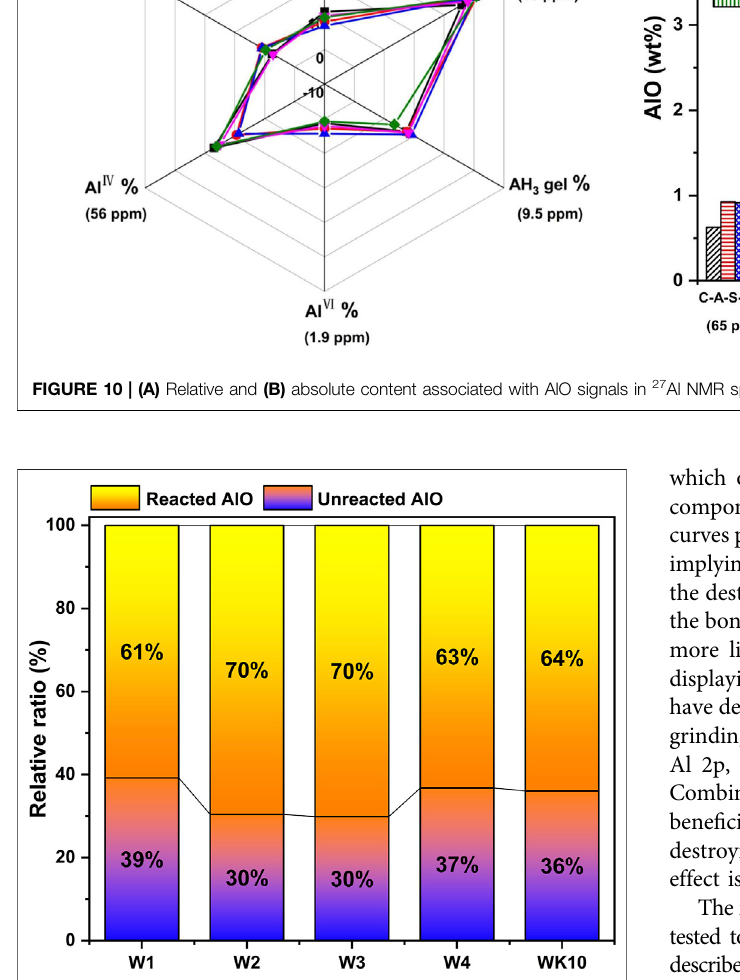
Frontiers in Physics |